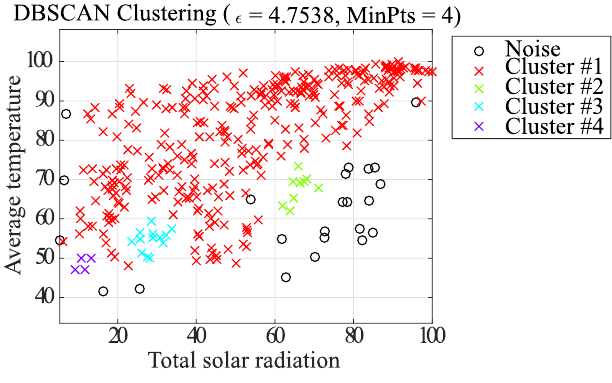
Figure 4. DBSCAN results (before